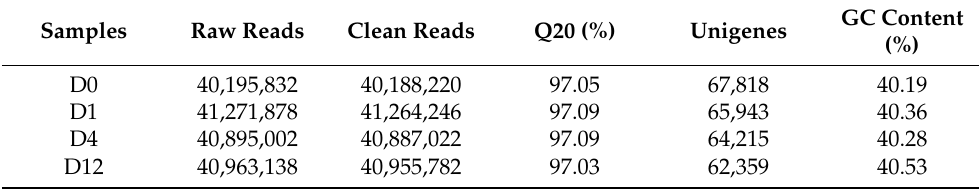
Table 1. Summary of Illumina RNA-sequencing data. Samples